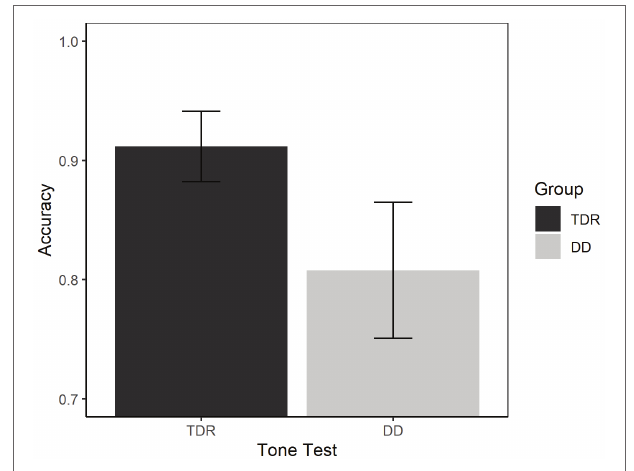
FIGURE 10 | Accuracy in auditory tasks. Error bars represent standard errors. TDR, typically developing readers, DD, developmental